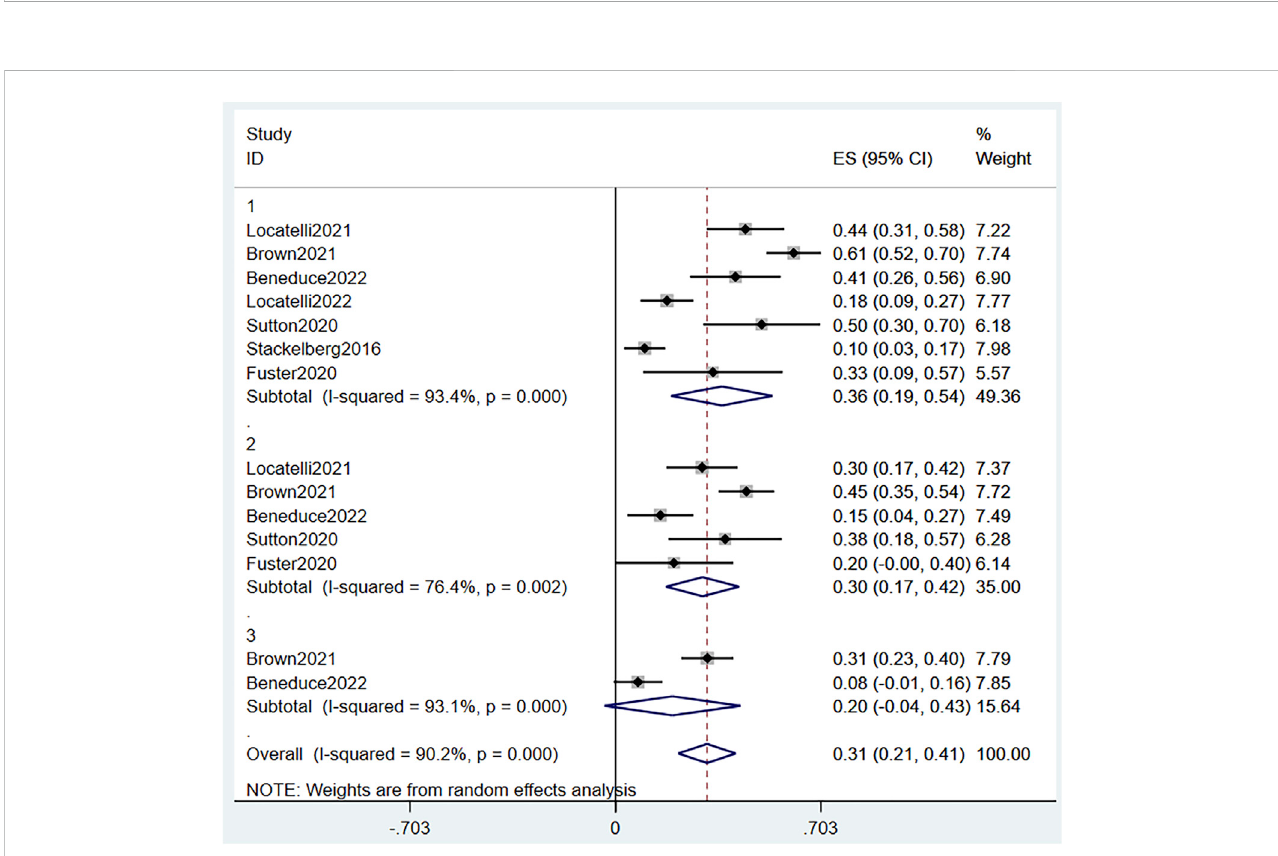
FIGURE 6 Forest plotofEFS(single-arm studies).EFS,event-freesurvival;95% CI,95% con fi denceinterval; ES:Effect Size;1,1-year;2,2-year;3, 3-year.Thesize of the rectangle at the center of the horizontal bar is proportional to the weight of the given study. The diamond at the bottom indicates the pooled ES.